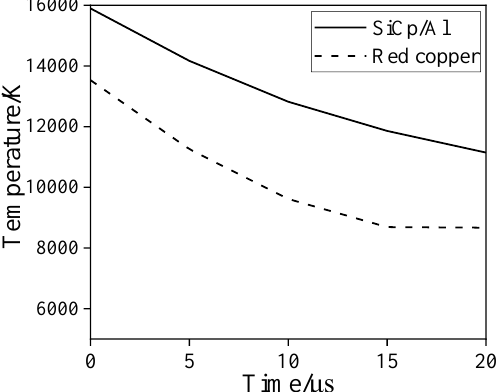
Figure 9. Curve of the maximum temperature of red copper and SiC p /Al with time.